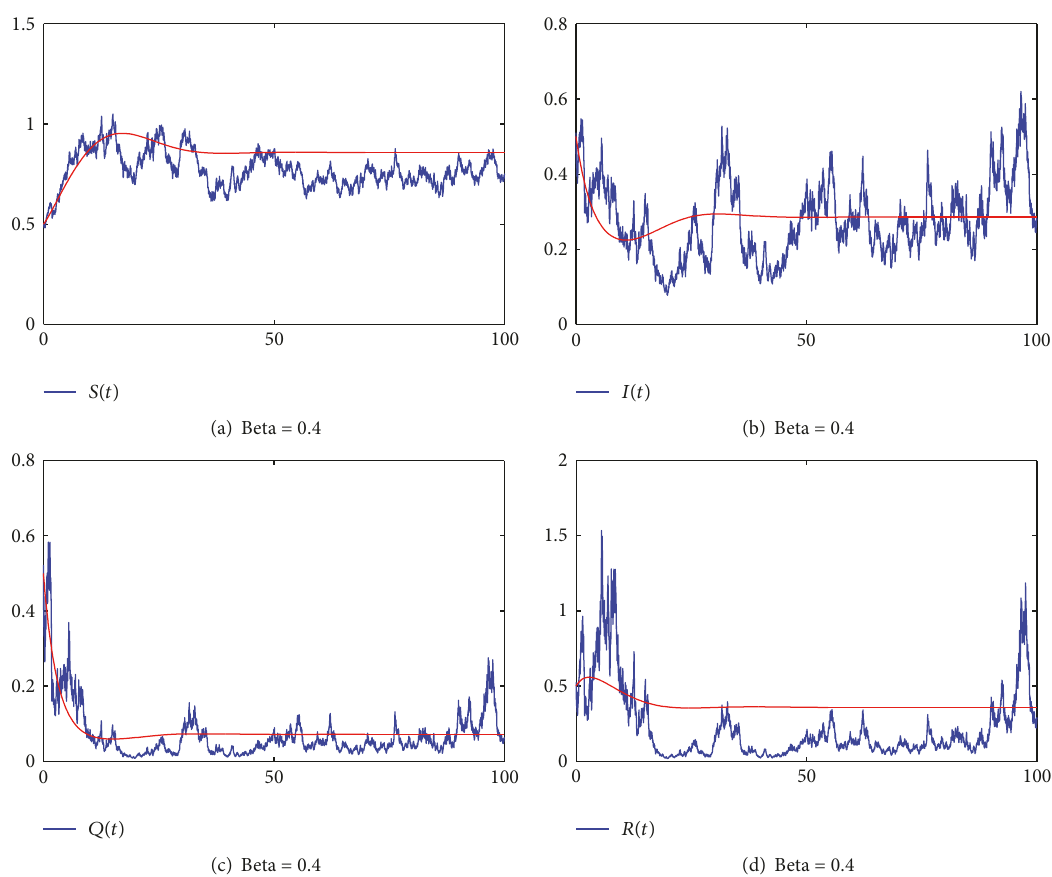
Figure 6: Computer simulation of the paths 𝑆(𝑡), 𝐼(𝑡), 𝑄(𝑡) , and 𝑅(𝑡) for models (1) and (3) for parameter values Λ = 0.2; 𝑑 = 0.1; 𝛽 = 0.7; 𝛾 = 0.1; 𝛿 = 0.1; 𝛼